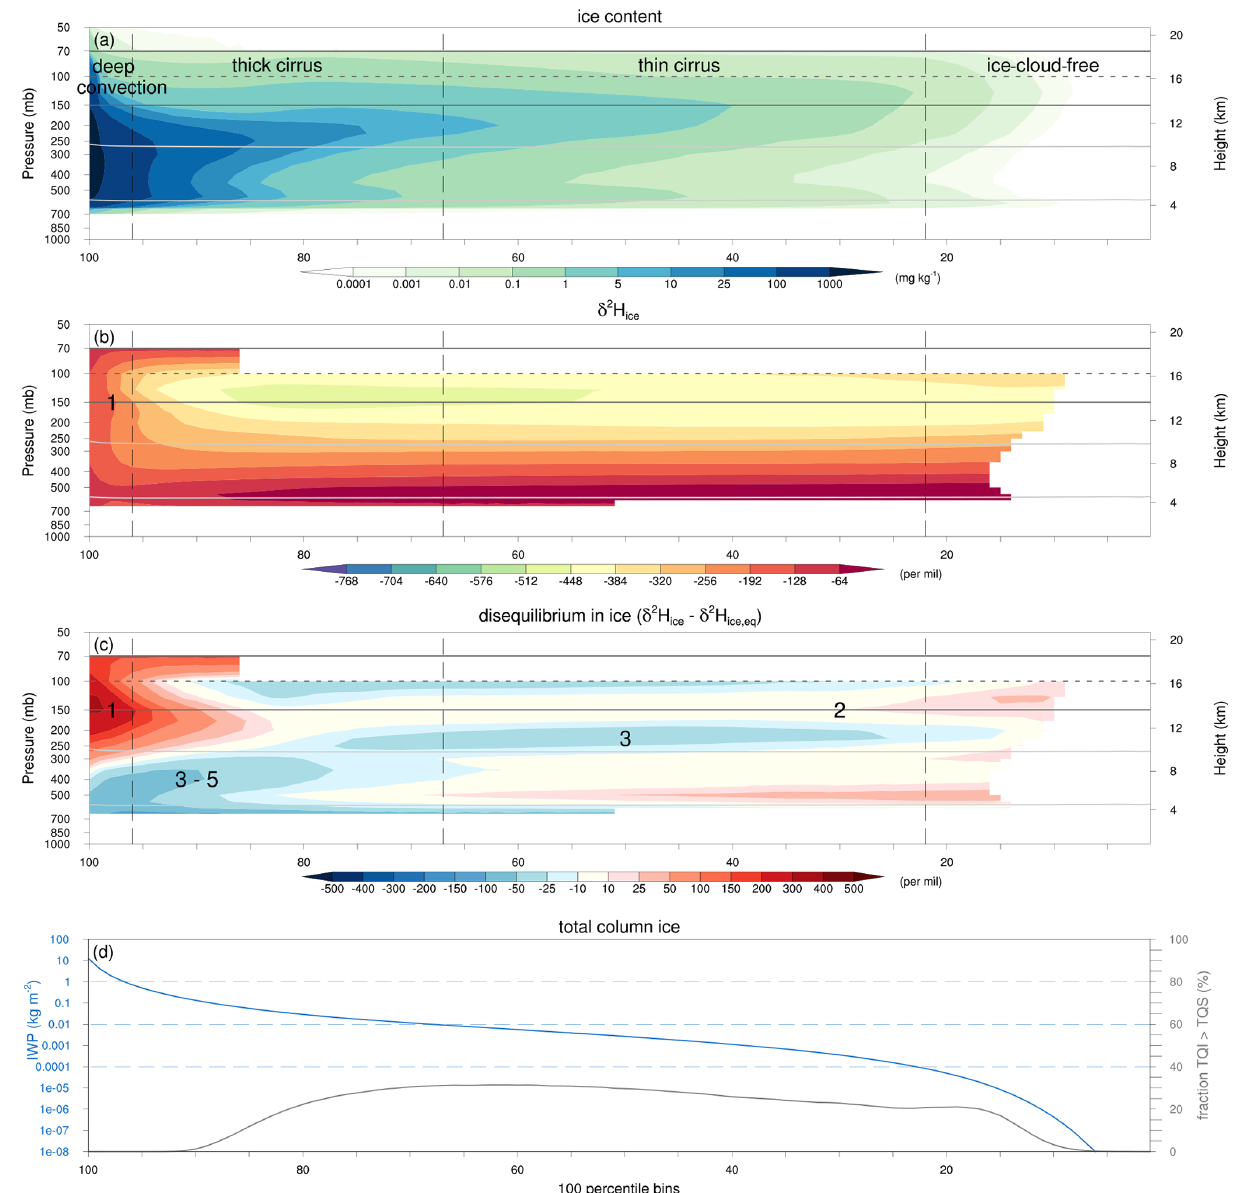
Figure 11. Vertical distribution of ice and its isotopic composition as a function of IWP in the region of interest for July 2016. Vertical profiles show the (a) ice content (mgkg − 1 ), (b) δ 2 H in ice (‰), (c) disequilibrium in ice (‰), and (d) IWP amounts (blue; kgm − 2 ) as well as the fraction of grid points with TQI > TQS (%), constructed using 100 percentile bins ranked on IWP; see the text for details. δ 2 H in ice and disequilibrium in ice values are transparent when the average ice content is below 10 − 4 mgkg − 1 .